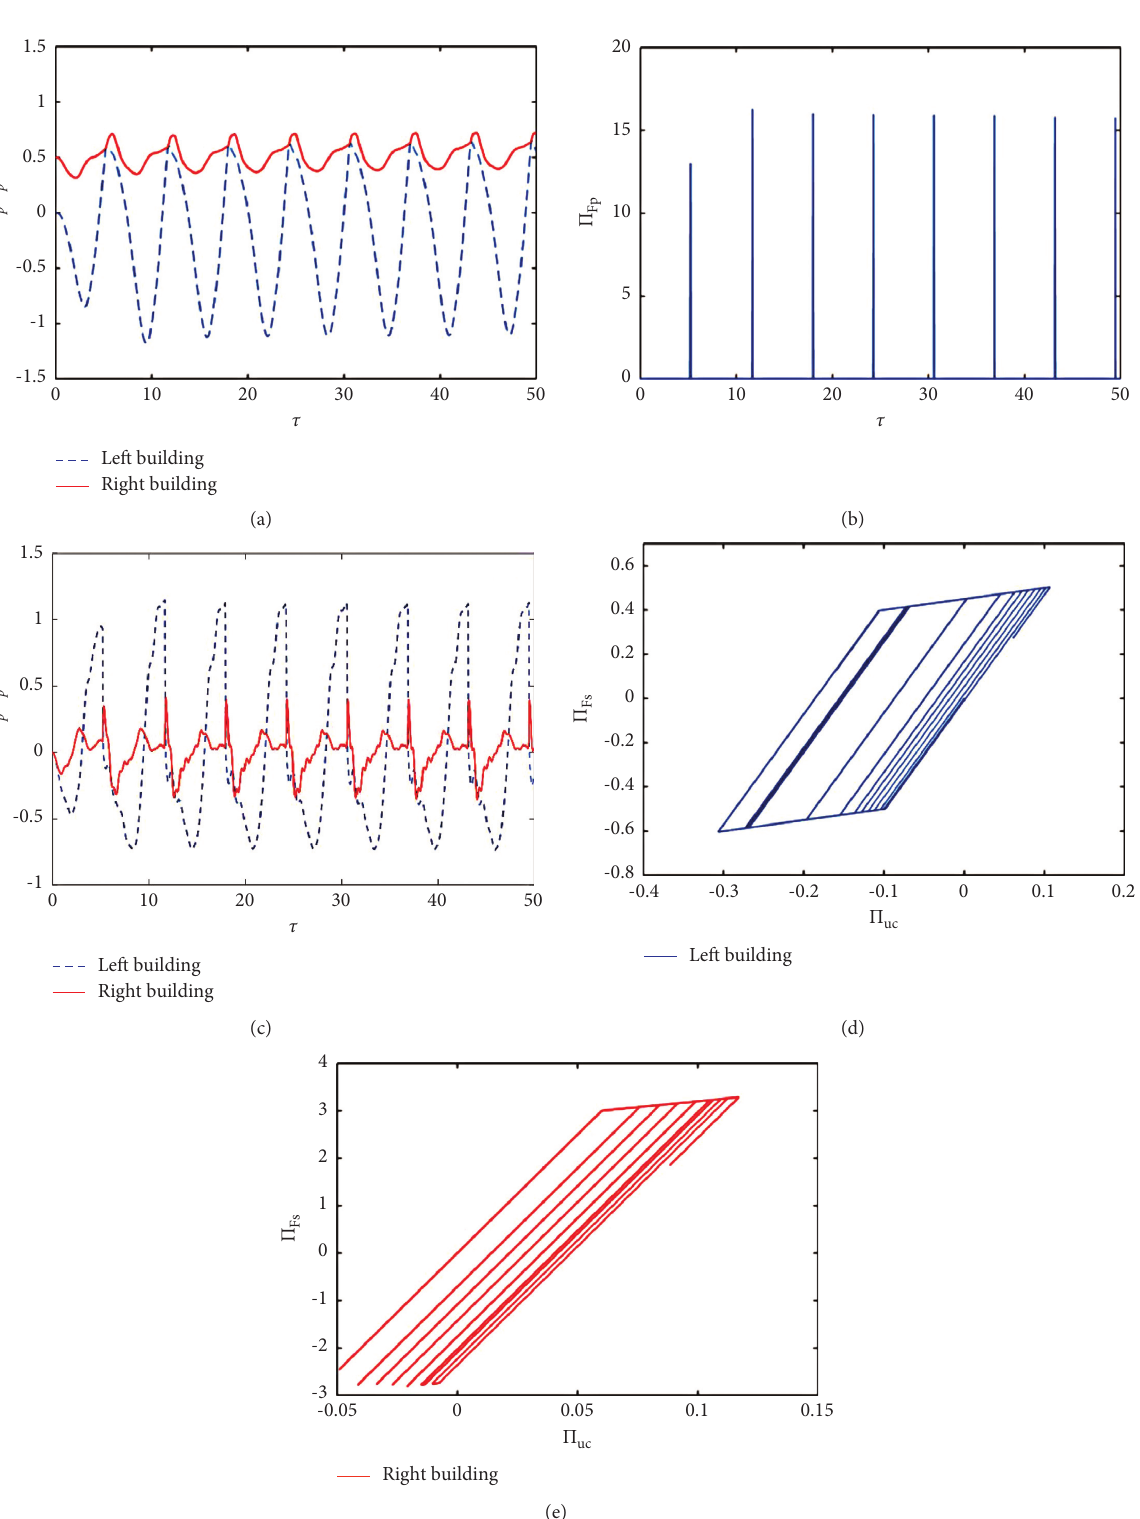
Figure 4: Displacement, velocity, pounding force histories, and hysteresis curves for the second story of adjacent buildings. (a) Dis- placement histories. (b) Pounding histories. (c) Velocity histories. (d) Hysteresis curve of the left structure. (e) Hysteresis curve of the right